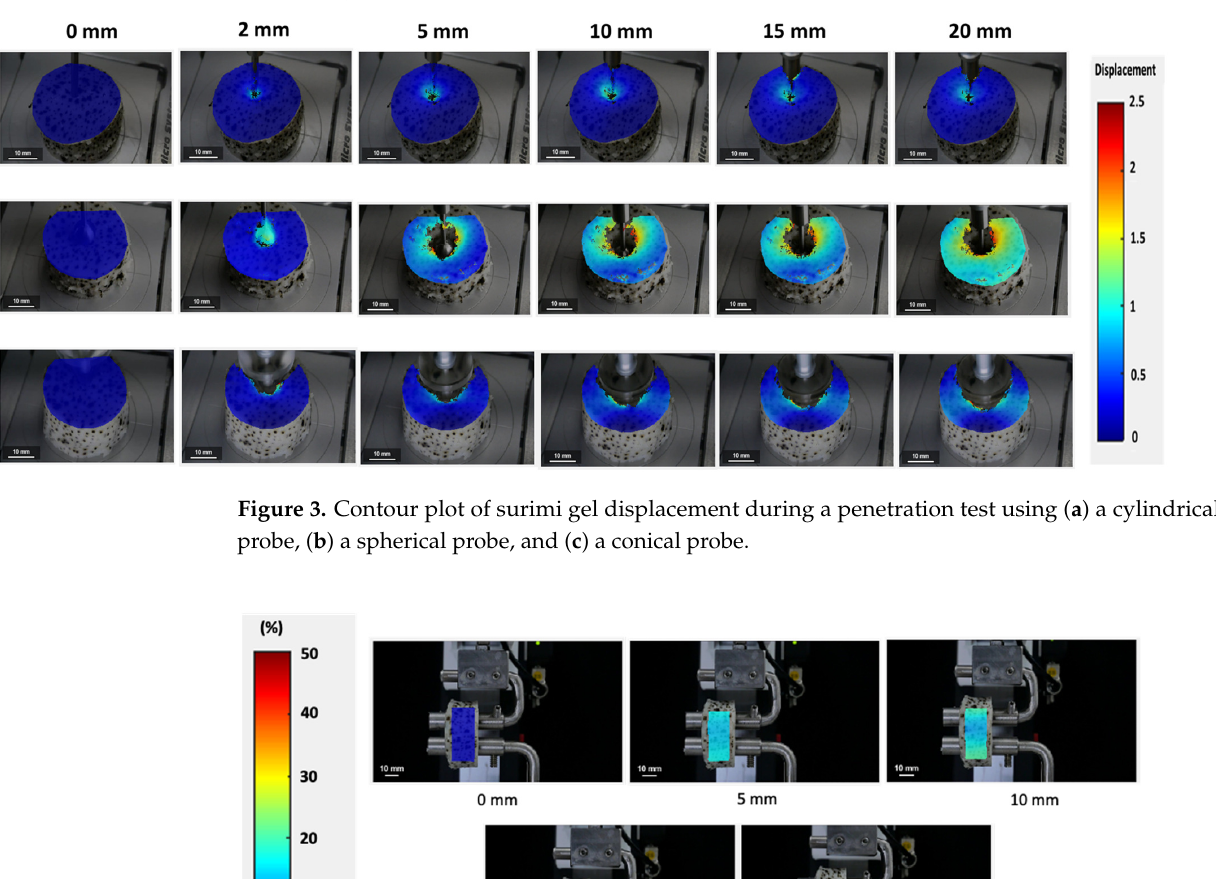
Figure 5. Contour plots of surimi gel displacement during the ring tensile test to the failure point.